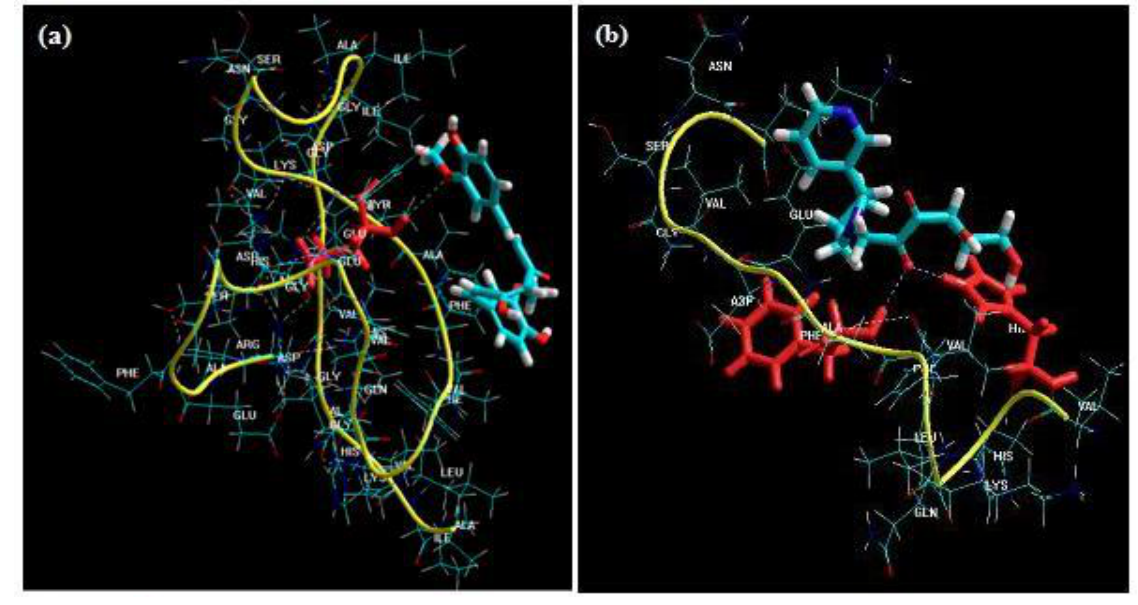
Figure 6. Visualization of binding of: ( a ) curcumin-glutamine acid [Aβ ( b ) glycosylated nornicotine- histidine and phenylalanine [Aβ The NEs and the H-bonded residues (red) are depicted in tube rendering.